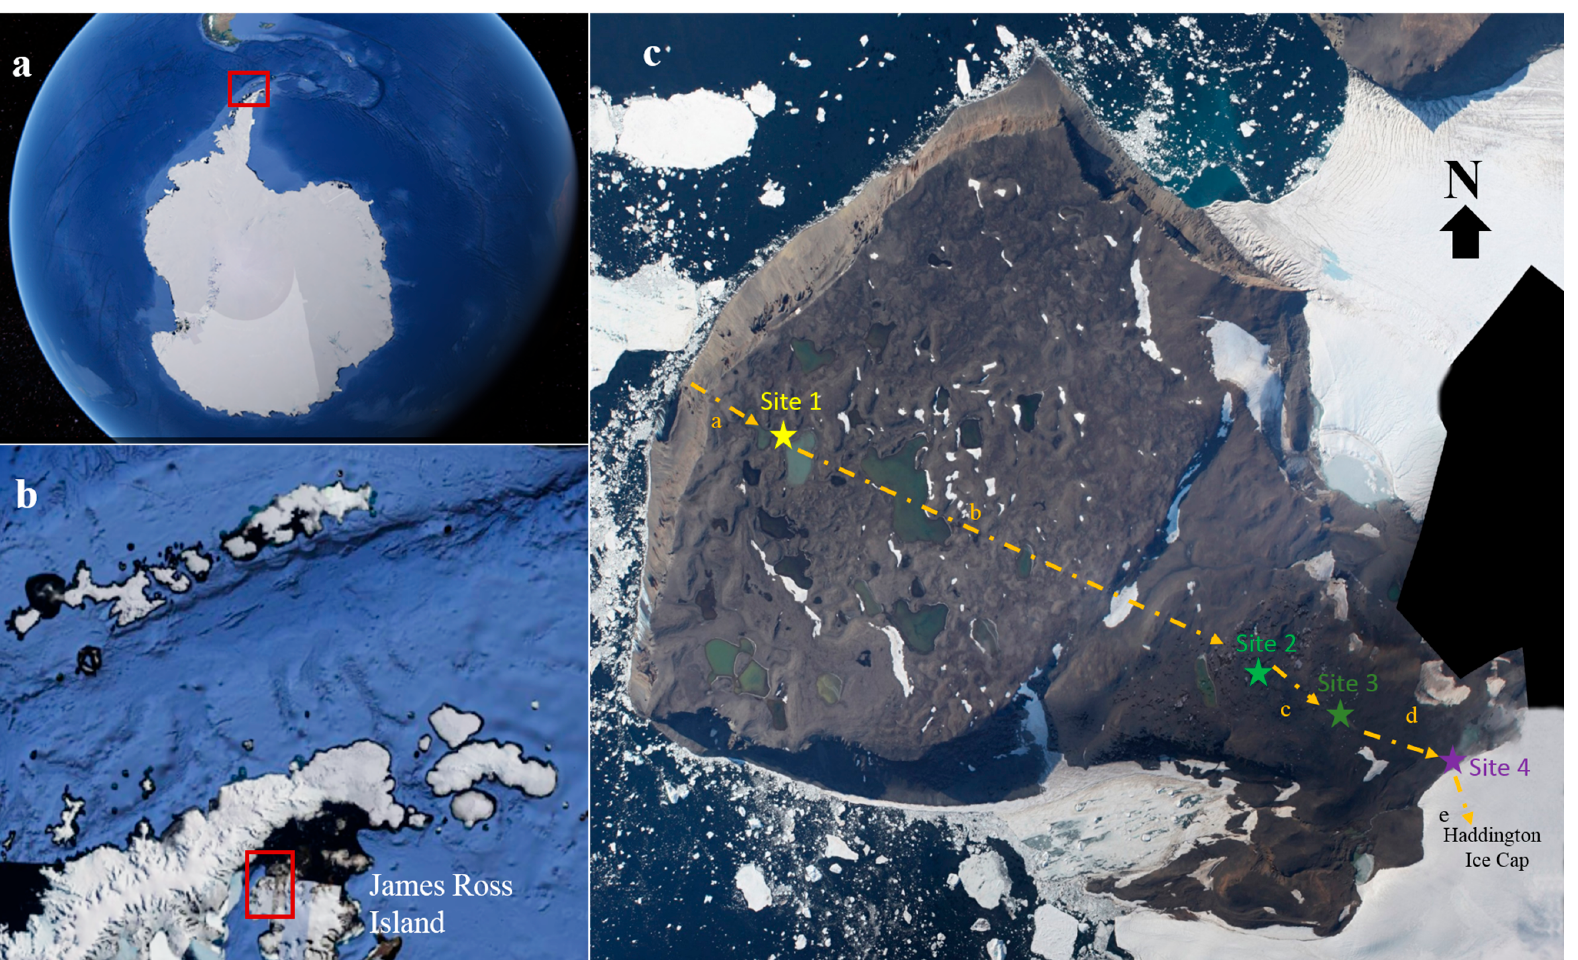
Figure 1. Satellite images ( a , b ) (obtained in Google Earth Pro, 2019). ( a ) Antarctica with the northern Antarctic Peninsula inside the red rectangle; ( b ) The western part of James Ross Island inside the red rectangle; ( c ) Clearwater Mesa with colored stars representing Site 1 (64 ◦ 01 (cid:48) 16.5 (cid:48)(cid:48) S; 57 ◦ 43 (cid:48) 49.6 (cid:48)(cid:48) W), site 2 (64 ◦ 01 (cid:48) 53.5 (cid:48)(cid:48) S; 57 ◦ 40 (cid:48) 47.0 (cid:48)(cid:48) W), Site 3 (64 ◦ 02 (cid:48) 03.6 (cid:48)(cid:48) S; 57 ◦ 40 (cid:48) 05.9 (cid:48)(cid:48) W) and Site 4 (64 ◦ 02 (cid:48) 09.5 (cid:48)(cid:48) S; 57 ◦ 39 (cid:48) 22.1 (cid:48)(cid:48) W) on James Ross Island. Photo c taken by Natacha Lopez. Yellow line represents the distances between the sites sampled: a = 650 m, b = 2700 m, c = 640 m, d = 730 m and e = 50